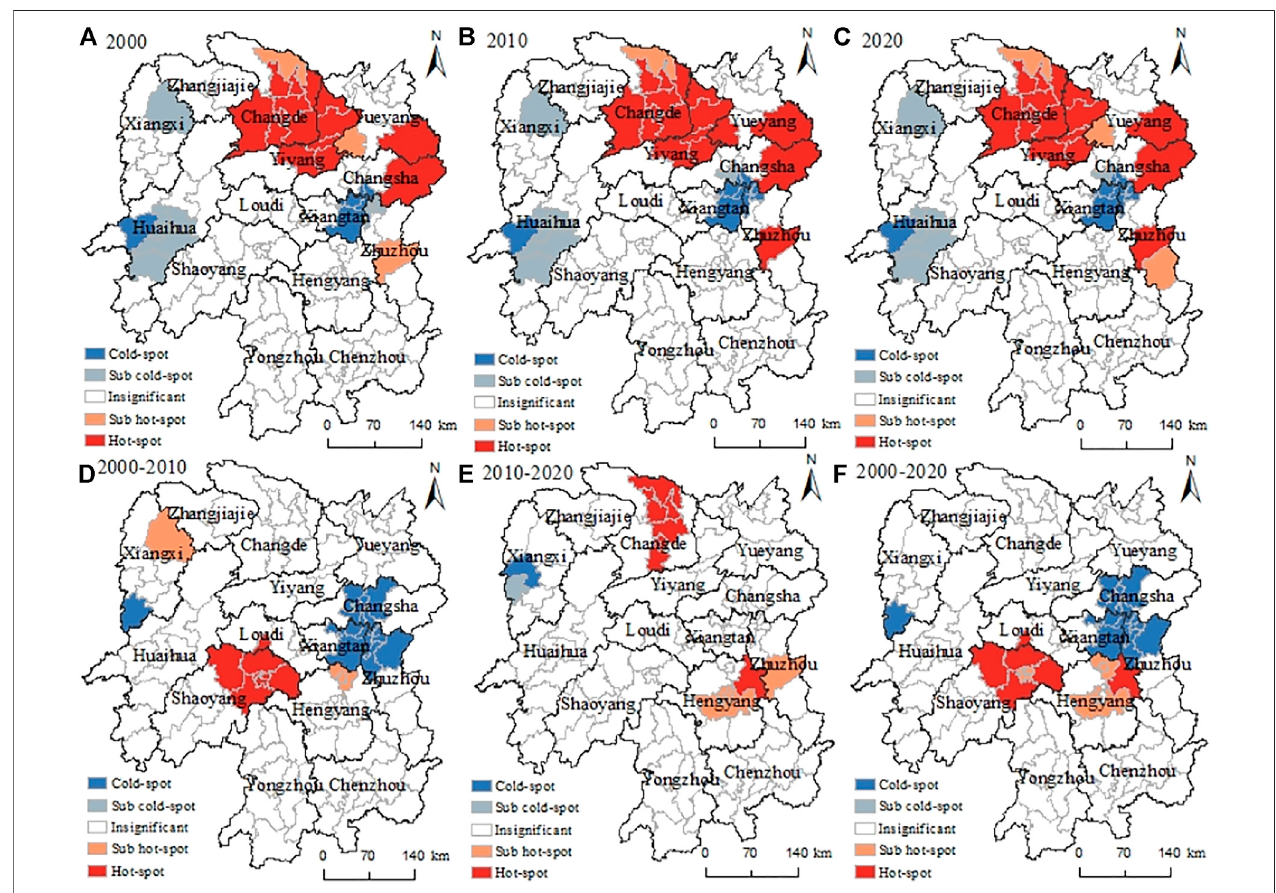
FIGURE 3 | Cold-spot and hot-spot distributions of the RRL area and change dynamics at the county level in Hunan Province from 2000 to 2020. [Panels (A – C) show the distribution of cold spots and hot spots in the current area of RRL in various counties of Hunan Province in 2000, 2010, and 2020, respectively. Panels (D – F) show the distribution of the change dynamics of RRL in various counties of Hunan Province in 2000 – 2010, 2010 – 2020, and 2000 – 2020, respectively.]